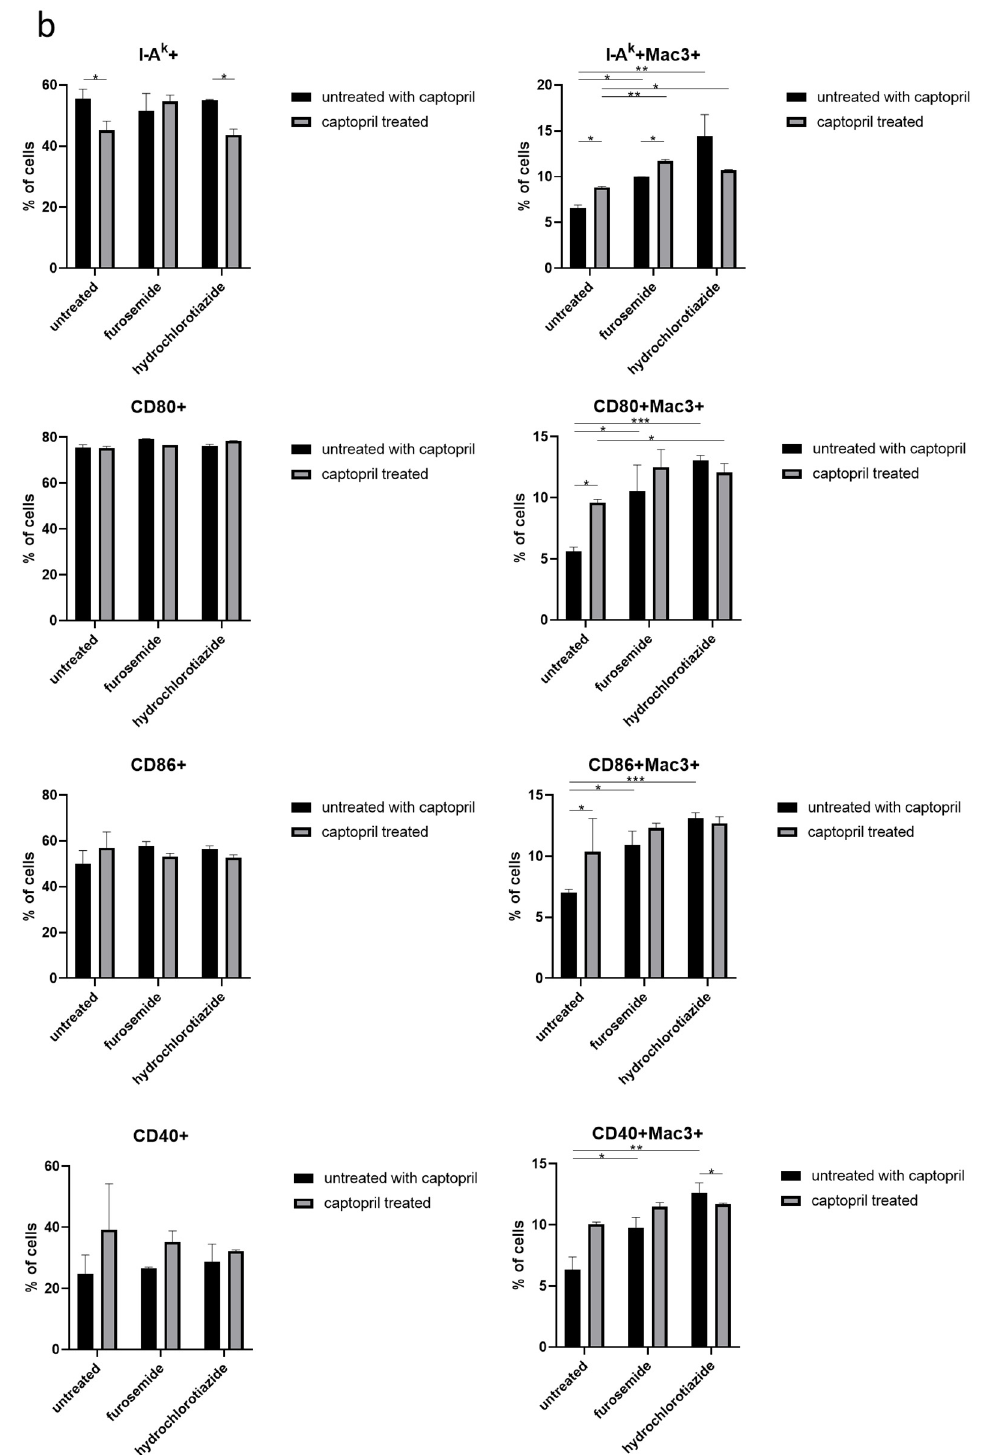
Figure 2. Captopril and diuretic drugs impact the expression of macrophage surface markers. ( a ) The level of expression of markers of phagocytosis (CD14, CD11b, CD16/32), and ( b ) antigen presentation, including I-A k (MHC class II), CD80, CD86, and CD40, was cytometrically assessed on the surface of oil-induced peritoneal macrophages from mice treated for eight days with captopril and/or respective diuretic drug. Results were shown as a mean percentage (with SD) of macrophages expressing a particular marker within either the total population of analyzed macrophages or their Mac3+ subpopulation. Two-way ANOVA with Tukey post hoc test. * p < 0.05; ** p < 0.01; *** p <